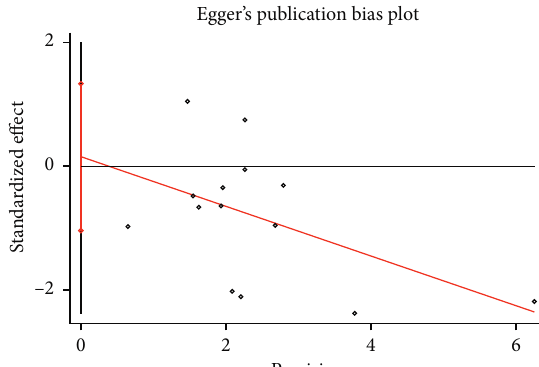
Figure 9: Comparison of MACE between the experimental group and the control group (Egger’s test). RR � risk ratio; MACE � major adverse cardiovascular events.